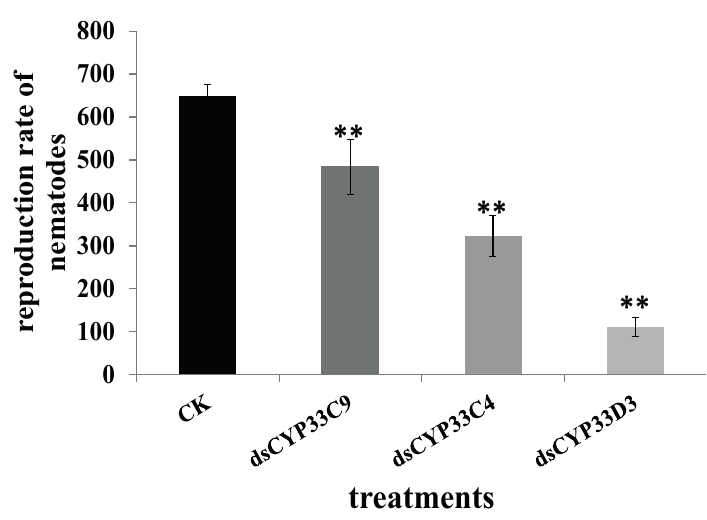
Figure 5. Effect of RNAi on reproduction of B. xylophilus . ( A ) RNAi-treated B. xylophilus after cultivation with B. cinerea ; ( B ) Reproduction rate of B. xylophilus washed from PDA plate of B. cinerea with and without dsRNA (ds CYP33C9 , ds CYP33C4 and ds CYP33D3 ) treatment. B. xylophilus soaked in ddH 2 O were used as controls. Data represent mean values ± SD from three independent experiments. Bars show standard deviations of the mean. Asterisks on top of the bars indicate statistically significant differences (** p < 0.01, Student’s t -test) was found between the dsRNA-treated (ds CYP33C9 , ds CYP33C4 and ds CYP33D3 ) nematodes and controls.